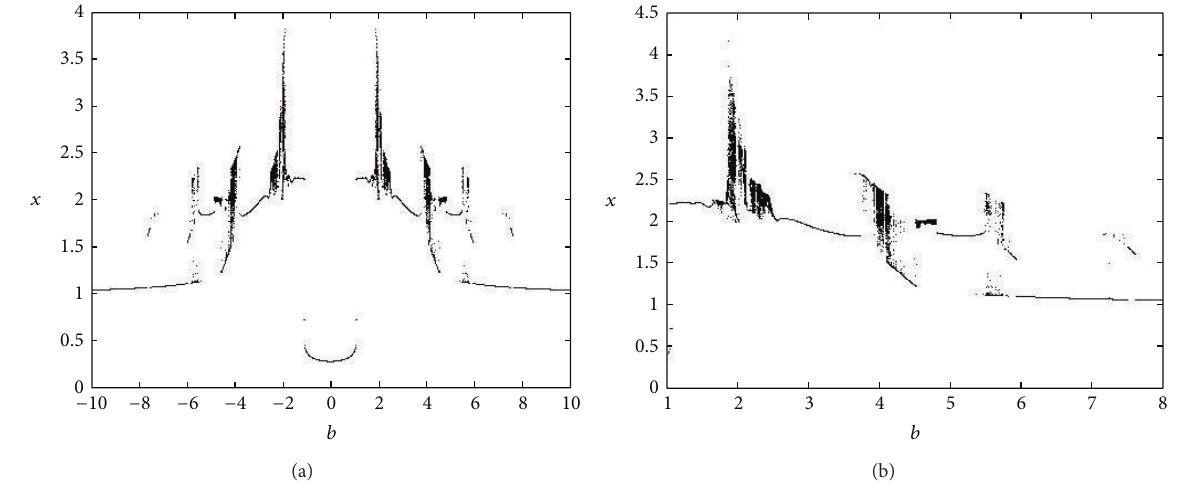
Figure 10: The bifurcation diagram about 𝑏